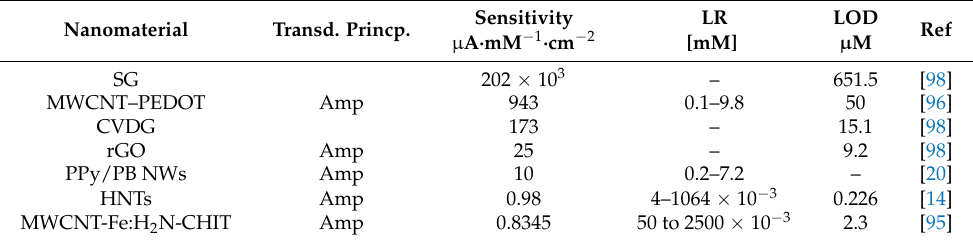
Table 4. Mixed nanostructures based H 2 O 2